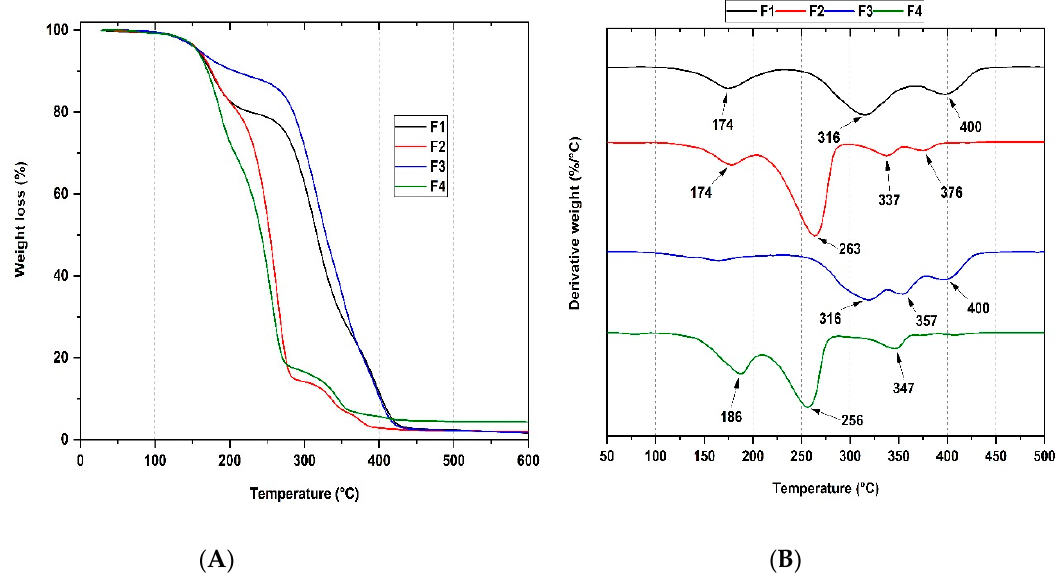
Figure 6. Thermogravimetric analysis of the PCL/PLA/ZnO-NPs/Gly/TTEO nanocomposites. F1, 25%PCL/70%PLA/5%Gly; F2, 22%PCL/70%PLA/5%Gly/3%ZnO-NPs; F3, 15%PCL/70%PLA/5%Gly/10%TTEO; F4, 17%PCL/70%PLA/5%Gly/3%ZnO-NPs/10%TTEO. ( A ): thermogram (TGA) of nanocomposites F1, F2, F3, and F4. ( B ): Derivative thermogravimetric analysis (DTGA) for the F1, F2, F3, and F4 nanocomposites.